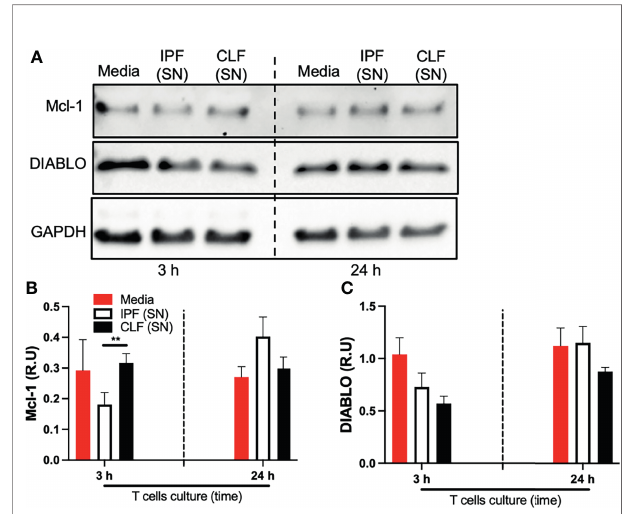
FIGURE 5 | The supernatant (SN) from IPF fi broblasts decreases Mcl-1 at the protein level in T cells at a short time of exposure. T cells obtained from four different healthy donors were stimulated with different IPF (SN) and CLF (SN) and recovered at the end of the culture. Then, Mcl-1 and DIABLO were examined by Western blot (A) . Band densities were normalized with GAPDH by densitometry analysis and results are shown in relative units (RU) of Mcl-1 and DIABLO concentration ( B, C , respectively) using ImageJ software. Bars indicate mean ± SD from four independent biological experiments. A multiple t -test and Holm – Sidak as post-test were used. ** p <